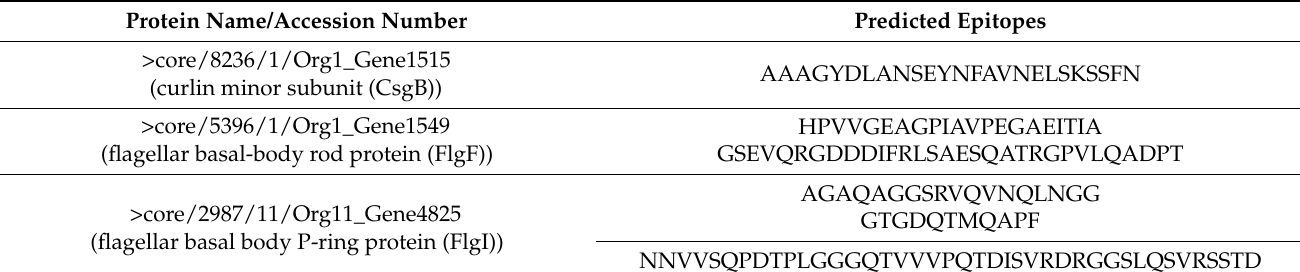
Table 1. Selected proteins and predicted B-cells epitopes.